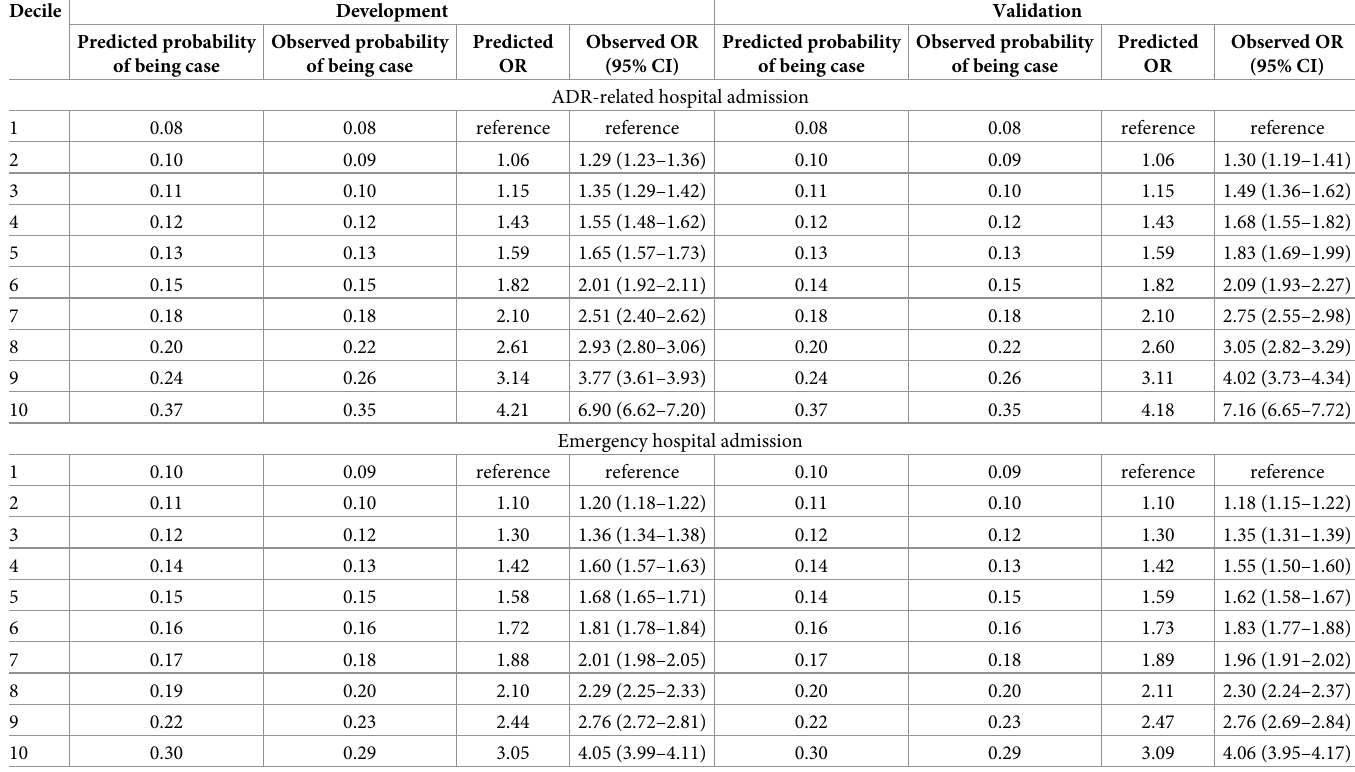
Table 2. Observed and predicted ORs of ADR-related and emergency hospital admissions stratified by deciles of predicted probability of being a case.